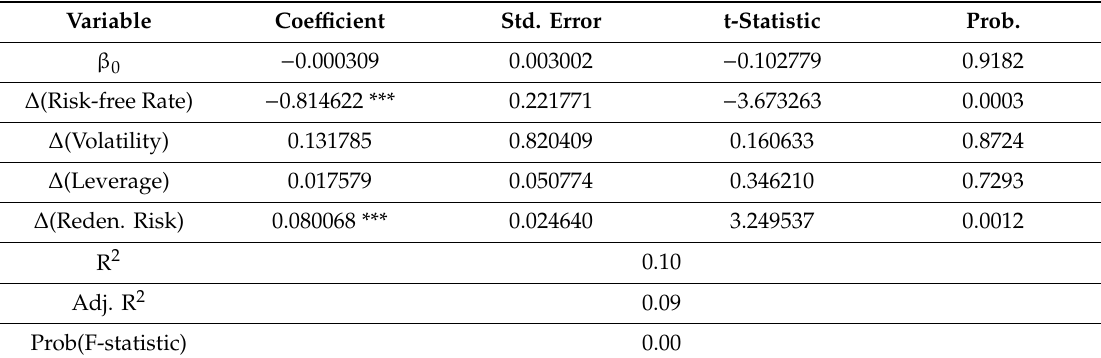
Table 3. OLS estimates: period August 2007–October 2009 (492